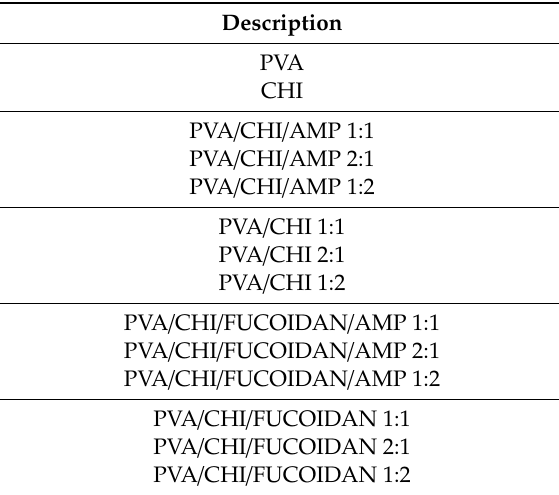
Table 1. List of the prepared BAPMs and the ratio of all the components.